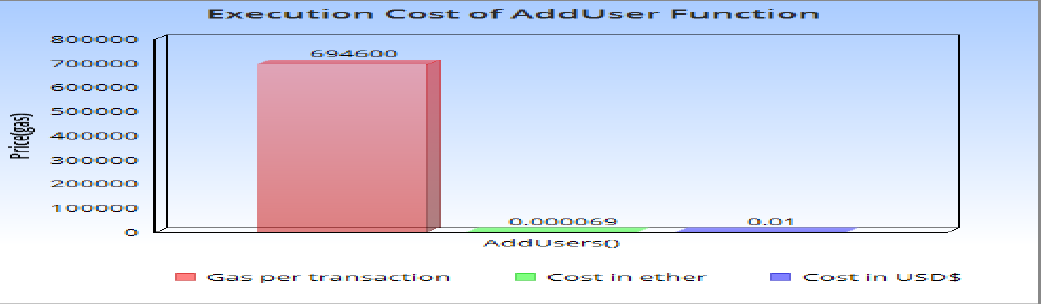
Fig. 4: Execution Cost of Add Users function